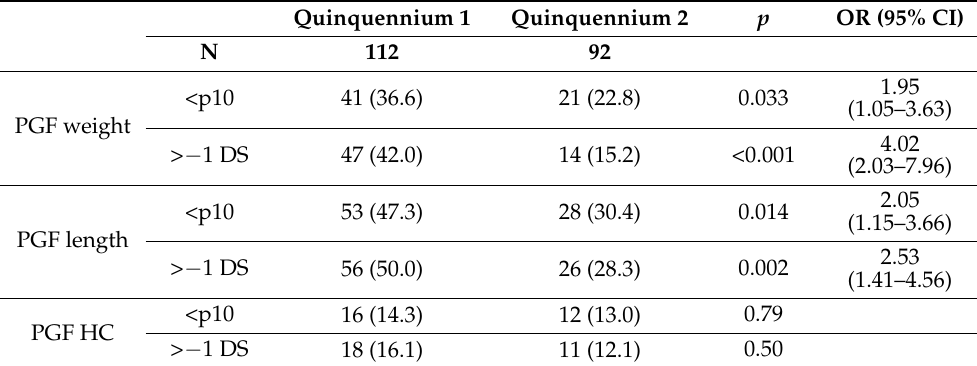
Table 3. Evolution of the prevalence of static postnatal growth faltering (PGF) (<p10 at discharge) and dynamic PGF (decrease in weight > 1 DS) in AGA VLBW children (quinquennium 1: 2002–2006 vs. quinquennium 2: 2013–2017).